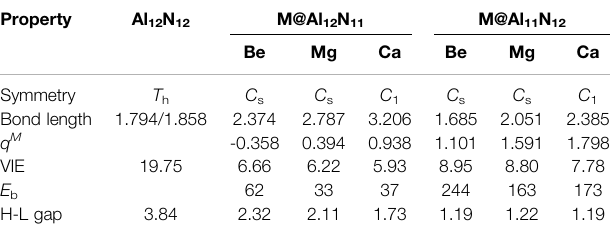
TABLE 1 | Symmetry, average M – Al bond length (in Å), average M – N bond length (in Å), HOMO – LUMO gap (H-L Gap, in eV), and vertical ionization energies (VIE, in eV) as well as the binding energy ( E b , in kcal/mol) and NBO charge of alkaline-earth metal atom for M@Al 12 N 11 and M@Al 11 N 12 (M = Be, Mg, and Ca). Property Al 12 N 12 M@Al 12 N